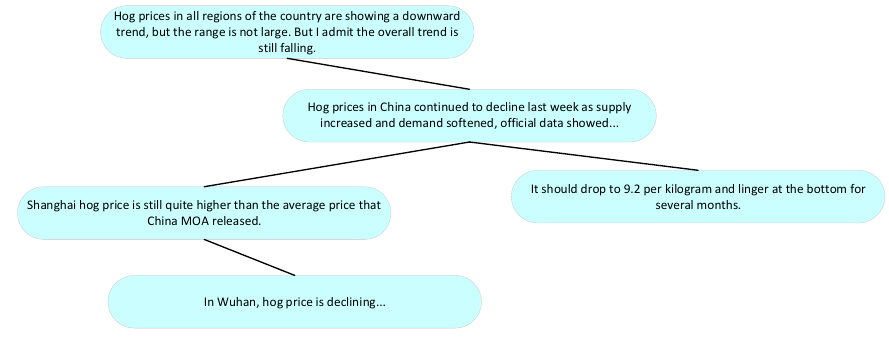
Figure 5. An example of the discussion